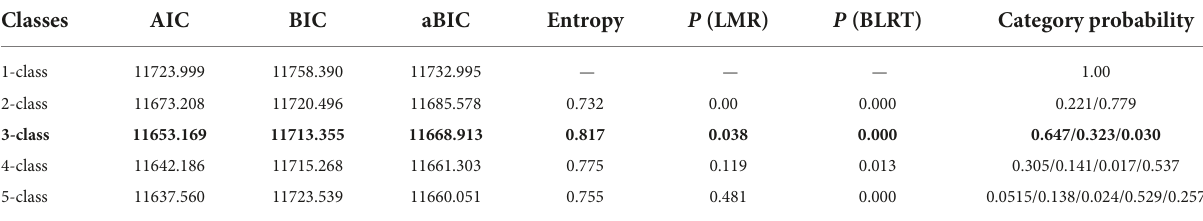
TABLE 1 Fitting indices for the trajectories of VT ( n = 544).